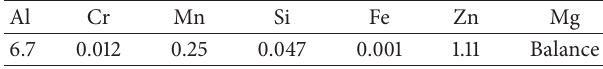
Table 1: Chemical composition of Mg-alloy AZ61 (% weight). Al Cr Mn Si Fe Zn Mg 6.7 0.012 0.25 0.047 0.001 1.11